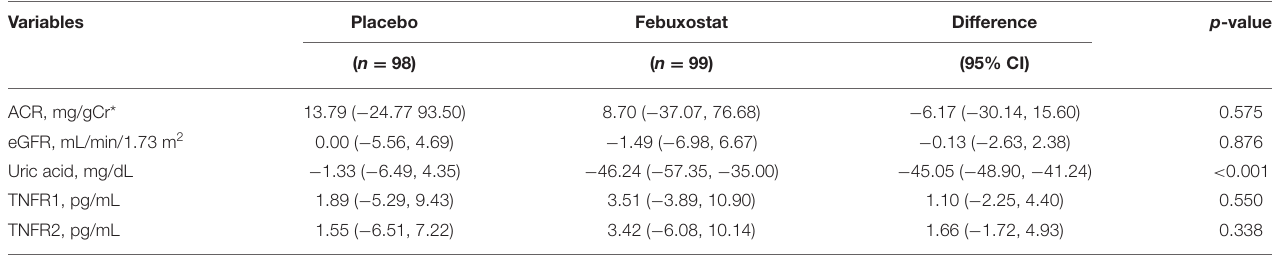
TABLE 2 | Percent changes in uric acid, TNFR1, and TNFR2 from baseline to week 12. Variables